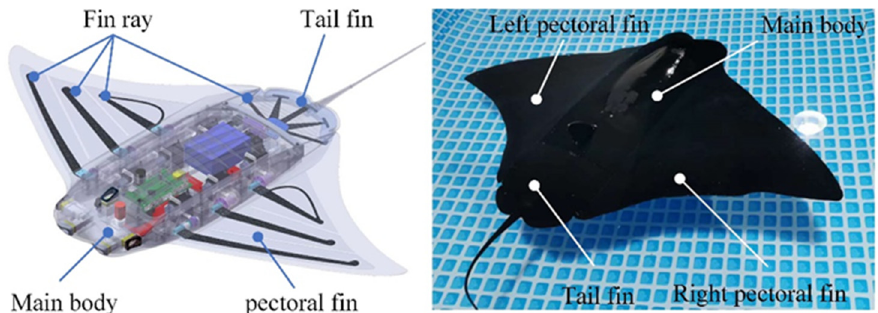
Figure 1. Model and physical images of the manta robot. The manta robot was configured to be more buoyant than gravity so that the manta robot would float on the water when at rest.